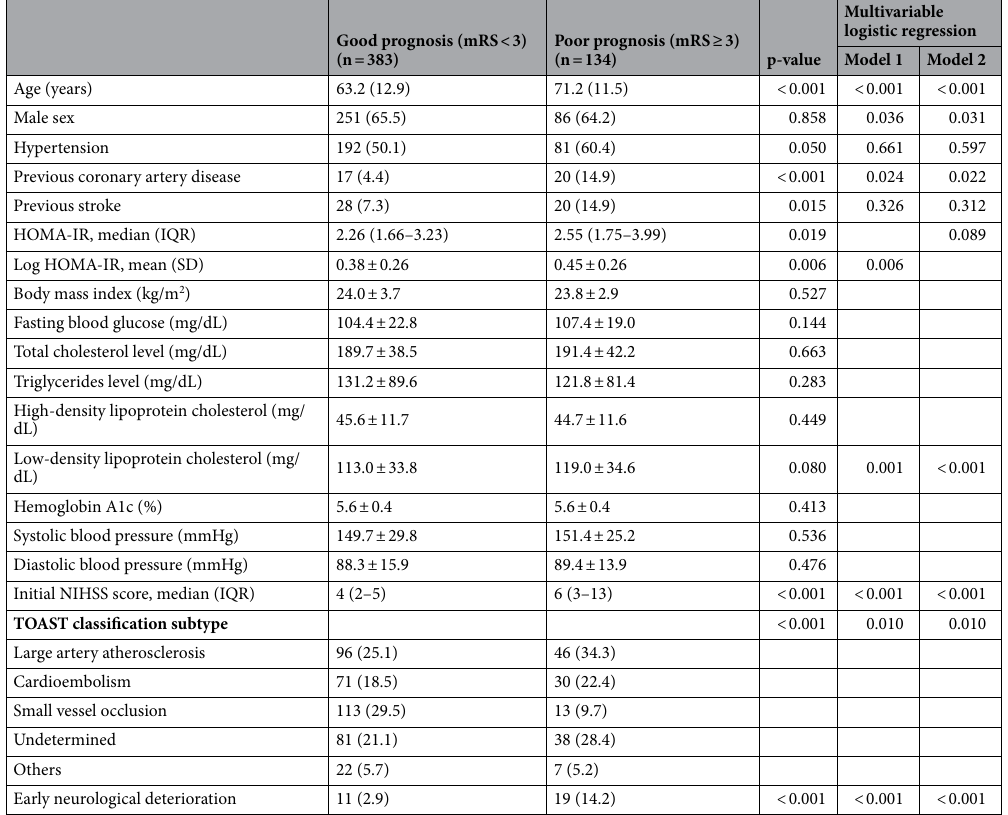
Table 2. Factors associated with poor functional outcome at 3 months after ischemic stroke. Data are expressed as the mean ± SD, or n (%). mRS, modified Rankin Scale; HOMA-IR, homeostasis model assessment of insulin resistance scores; IQR, interquartile range; NIHSS, National Institutes of Health Stroke Scale (NIHSS); TOAST, the Trial of Org 10,172 in Acute Stroke